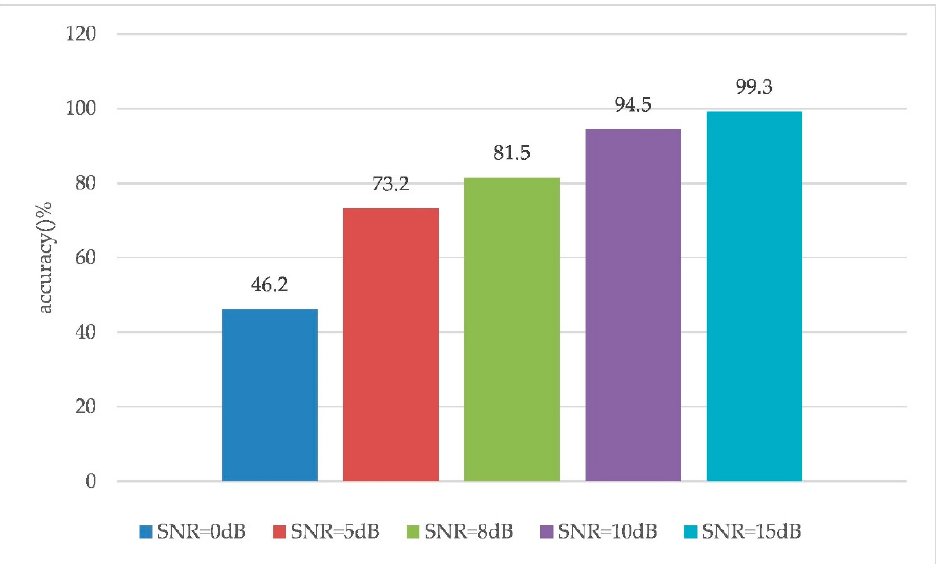
Figure 16. The test accuracy of the test set under different signal-to-noise ratio (SNR) conditions.